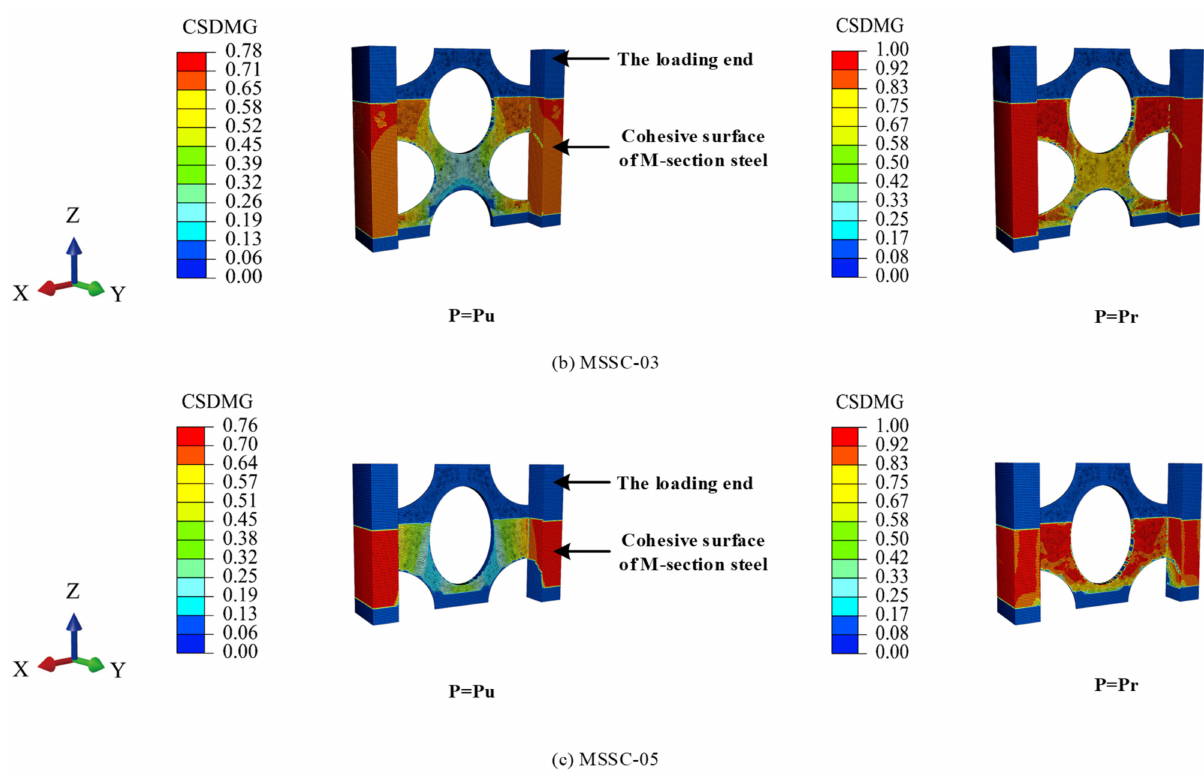
Figure 24. The process of MSSC specimen interface failure.